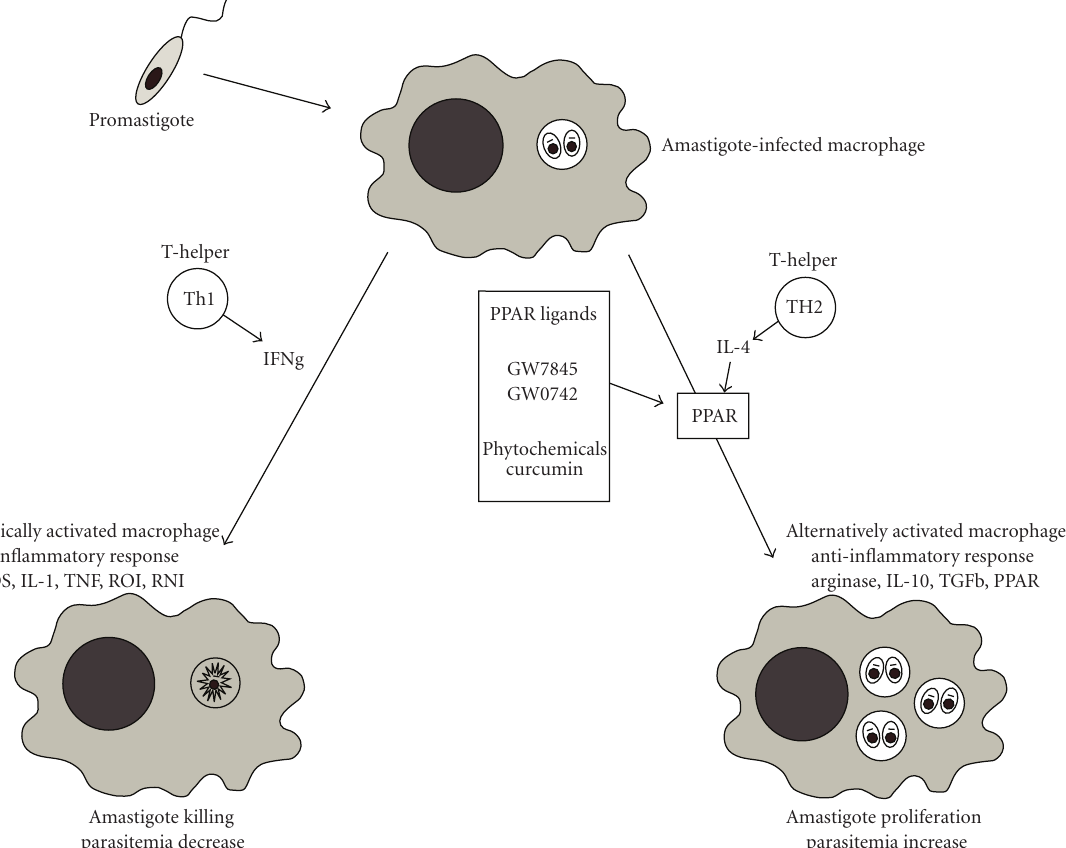
Figure 3: PPAR-mediating suppression of parasiticidal response in leishmaniasis. The sandfly vector carries leishmanial promastigotes to the mammalian host. The parasites then transform into amastigotes within phagolysosomes of host macrophages. Type 1 immunity, with T helper 1 (Th1) releasing interferon γ (IFN γ ), leads to classically activated macrophages (caMac). CaMac produce nitric oxide from inducible nitric oxide synthase (iNOS), interleukin-1 (IL-1), tumor necrosis factor (TNF), and reactive oxygen and nitrogen intermediates (ROI, RNI) that act to eliminate the amastigotes. Type 2 immunity, with Th2 releasing IL-4, leads to activation of peroxisome proliferator-activated receptor (PPAR) and alternatively activated macrophages (aaMac). AaMac produce arginase, IL-10, transforming growth factor β (TGF β ), and PPAR that allow amastigote propagation. PPAR agonists (GW7845 and GW0742) and some phytochemicals (curcumin) can activate PPAR and promote aaMac maturation. Activation of PPAR allows parasite survival as a chronic parasitic